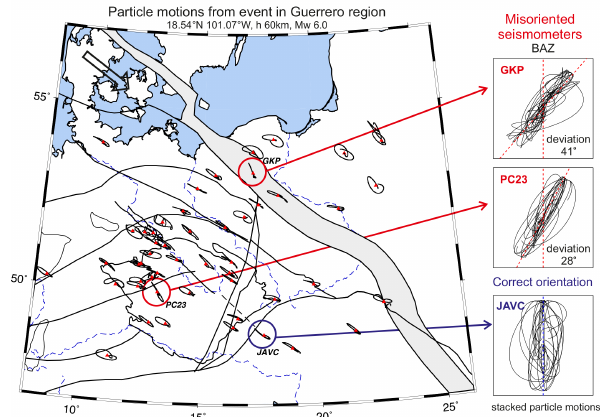
Figure 5. Horizontal shear-wave particle motion (PM) across the PASSEQ array for an event from the NW (left), located in Guer- rero region, documenting incorrect northward orientation of seis- mometers at stations GKP and PC23. PMs rotated to the back az- imuths and stacked for all events evaluated at stations PC23 and GKP with misoriented seismometers, and correctly aligned seis- mometer at JAVC (right). Only sufficiently large errors ( ∼ > 10 ◦ ) in seismometer misorientation can be revealed by this method. Smaller deviations of the PM can be caused by a weak anisotropy in the up- per